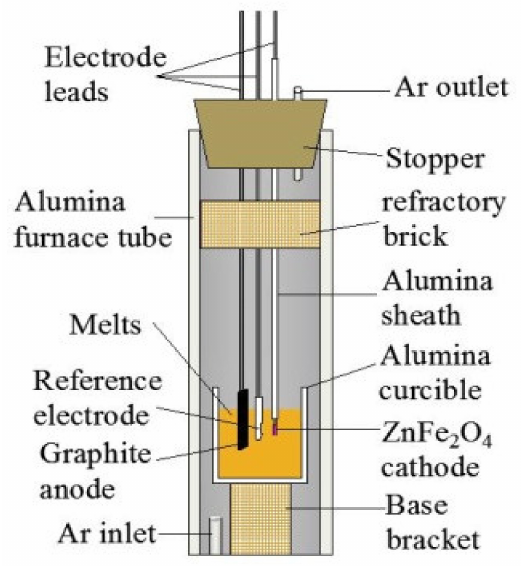
Figure 1. Three-electrode system